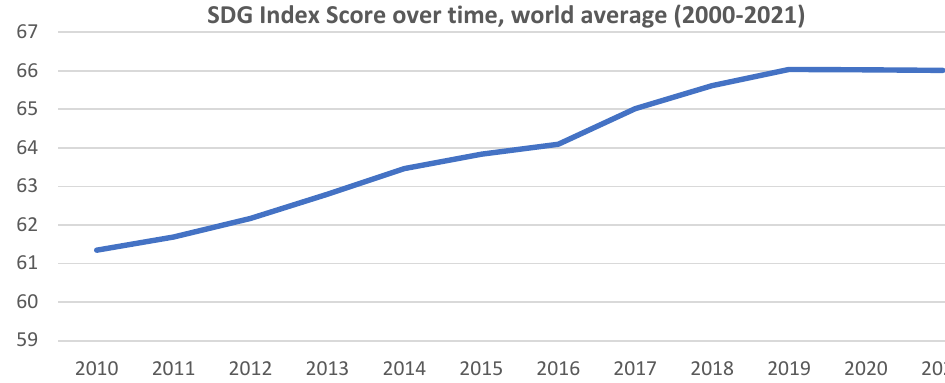
Figure 2. SDGs Index score over time, world average (2010 – 2021). Source: our own elaboration on Sachs et al. [46].